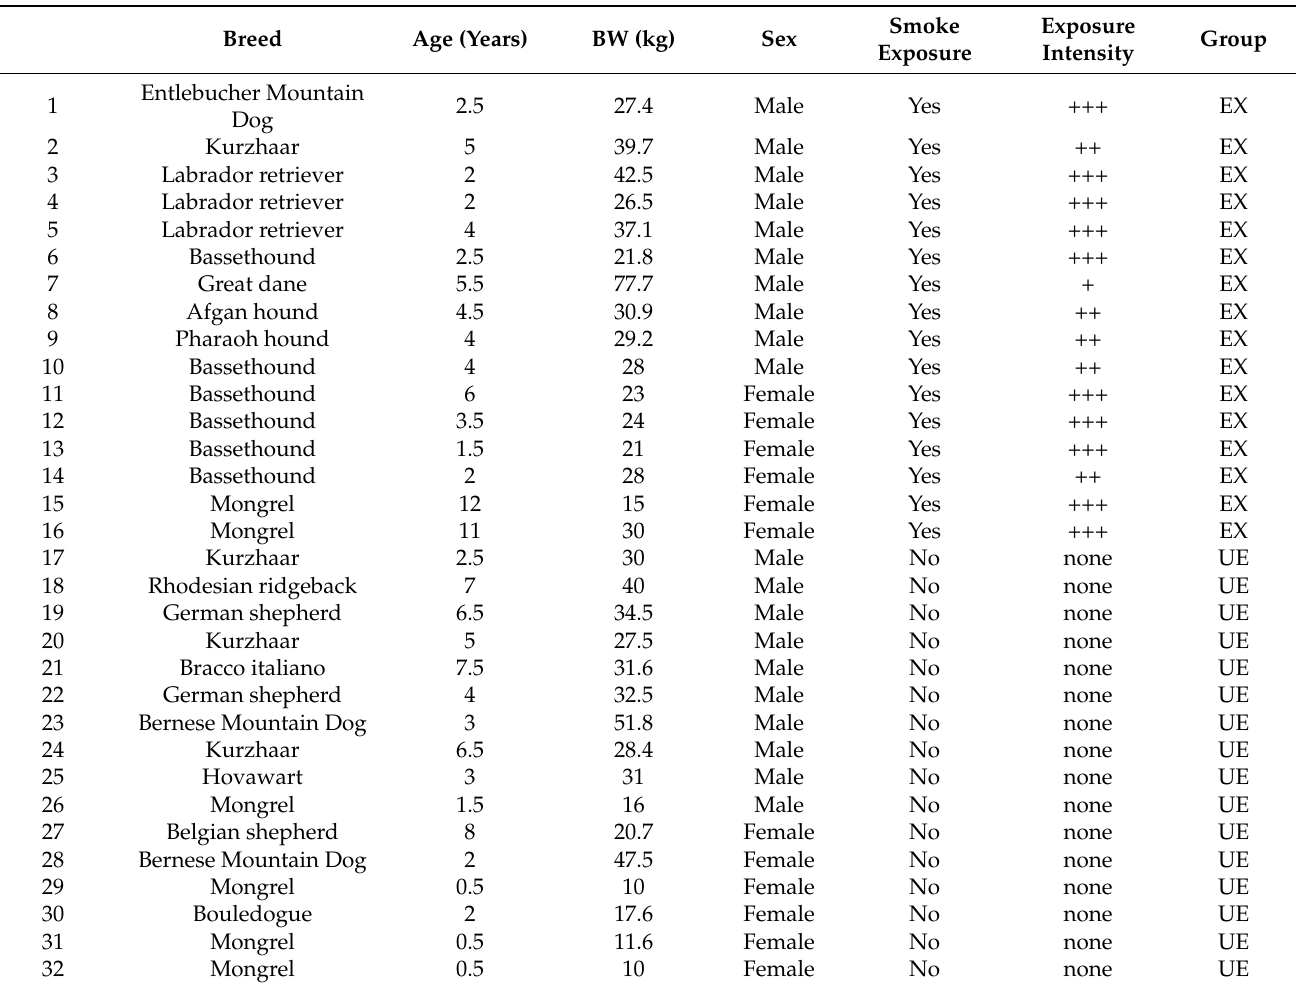
Table 1. Main data of dogs that were enrolled in this